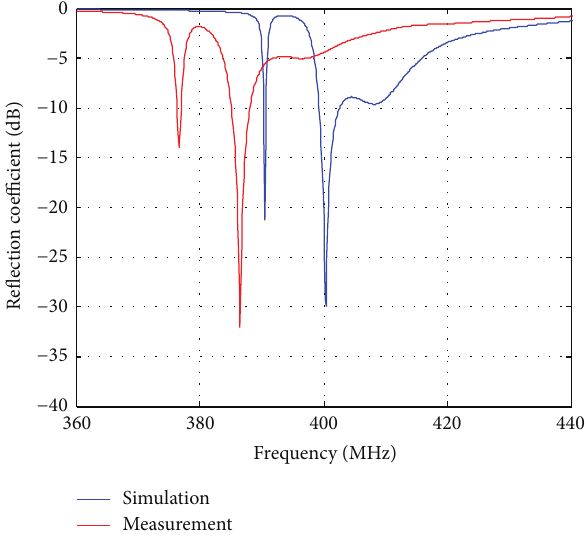
Figure 10: Simulated and measured antenna reflection coefficients.